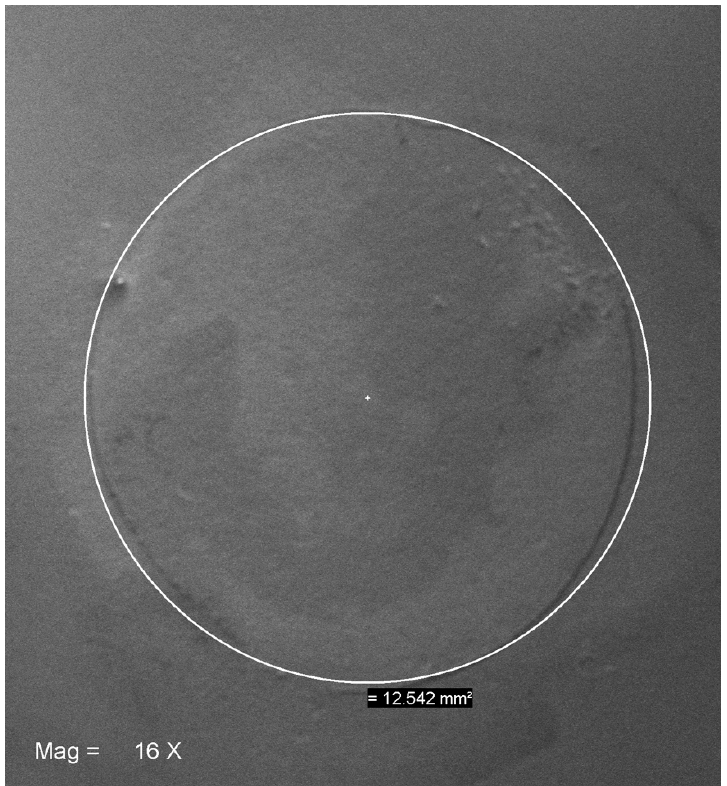
Figure 3. SEM assay of the adhesive cross-sectional area ( ≅ 12.54 mm 2 ) onto a representative Y-TZP specimen. Mag 16×.